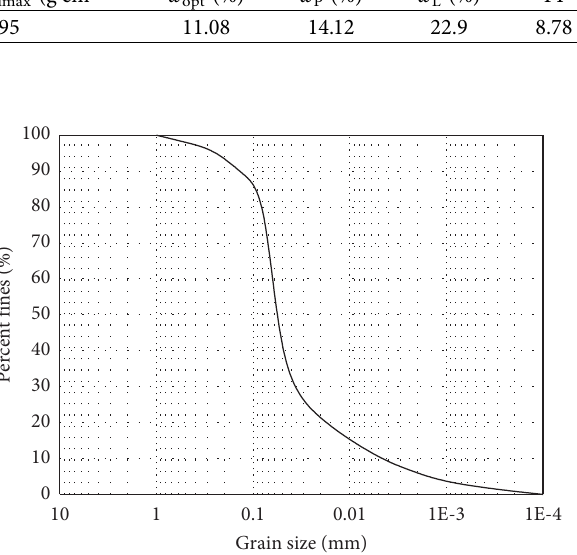
Figure 1: Grading curve of the experimental soil.